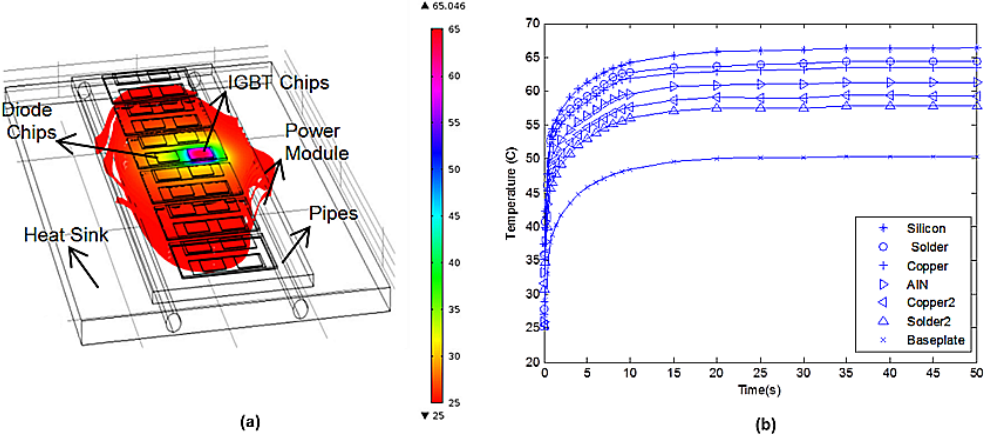
Figure 4. ( a ) Temperature distribution due to heating ( b ) layer temperature and fitted